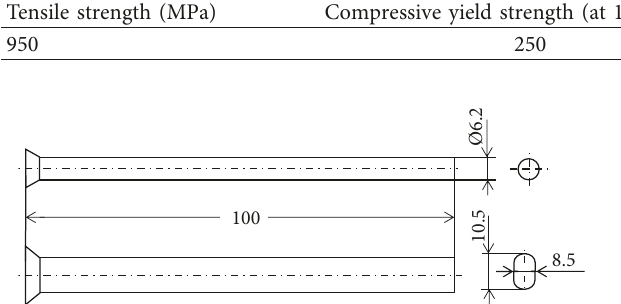
Table 2: Mechanical properties of DIN EN 10111-98 sheet metal steel (by the sheet metal supplier). Tensile strength (MPa) Compressive yield strength (at 149 ° C)(MPa)